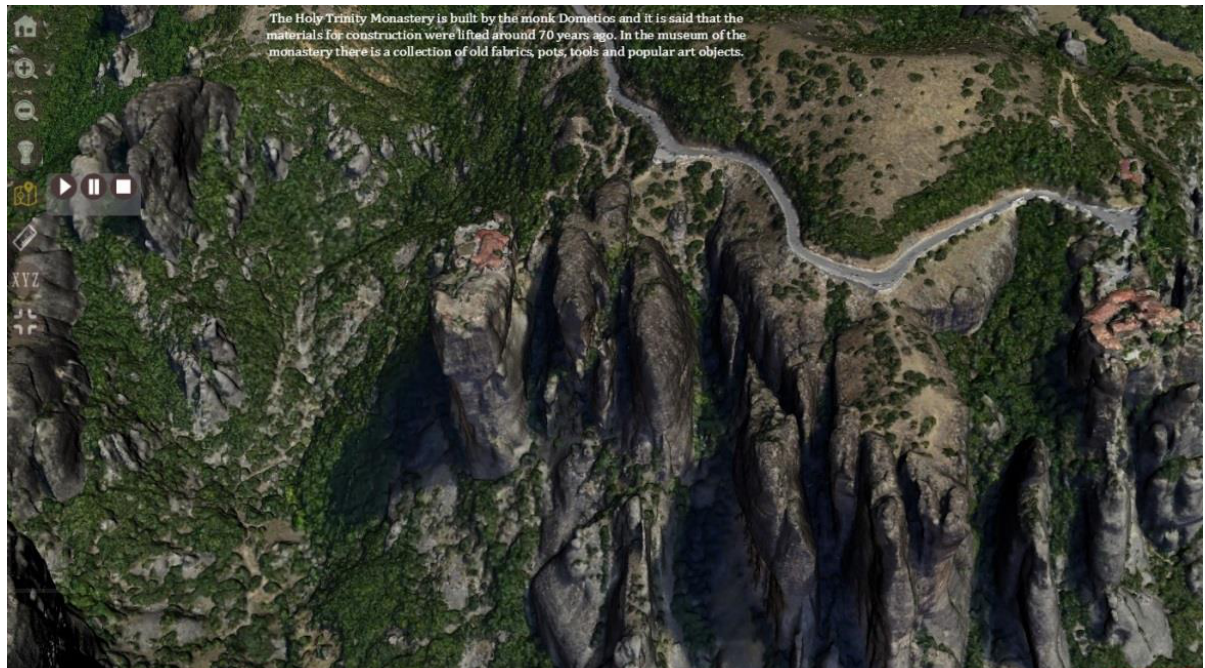
Figure 4. During the guided tour, a brief description is provided when camera is framing the “Holy Trinity”